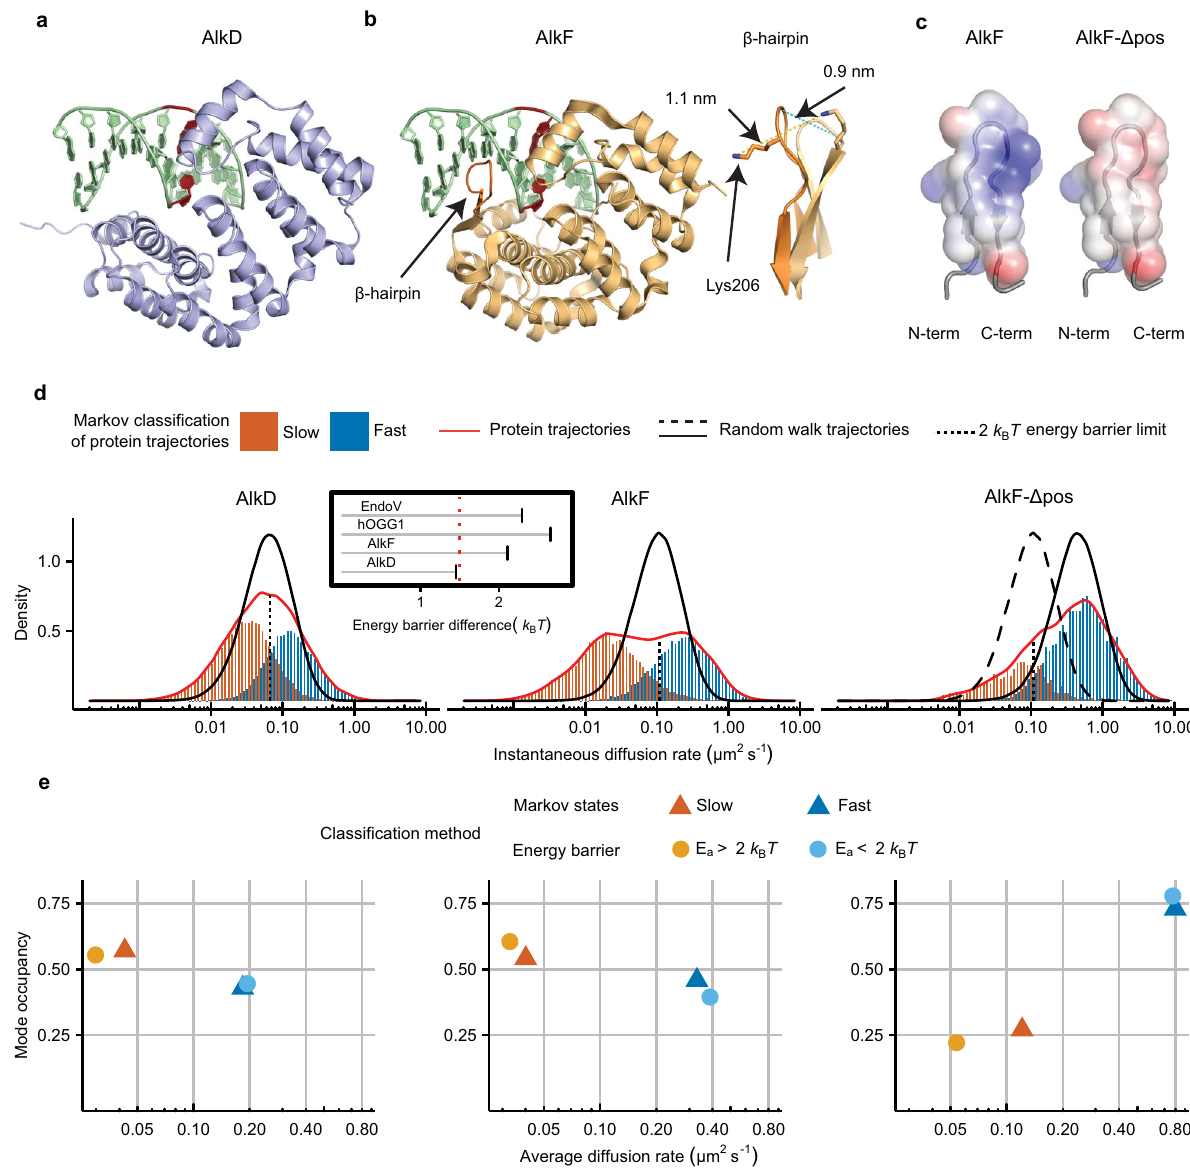
Fig. 2 DNA-scanning analysis of AlkD, AlkF, and AlkF- Δ pos. a Crystal structure of B . cereus AlkD binding to DNA with 3-deaza-3-methyladenine (red base). PDB code: 3JX7 4 . b Model of AlkF – DNA using the crystal structure of B. cereus AlkF without DNA (PDB code: 3ZBO 10 ) superposed onto AlkD bound to DNA. The β -hairpin of AlkF (dark orange; arrow) is protruding into the DNA major groove; Inset: a close-up view of the β -hairpin showing the fl exibility of the loop structure. c a close-up view of the wild-type AlkF and AlkF- Δ pos mutant, respectively, showing the difference in surface charge (blue/red correspond to 3/ − 3 k B Te – 1 ). d Overall instantaneous diffusion rate distributions (red curves) and classi fi cation of trajectories using a hidden Markov model, with the blue and orange histograms showing the individual distributions for the fast and slow modes of the scanning, respectively. These modes represent fractions of the movement with relatively higher and lower diffusion rates for each protein independently and do not necessarily correlate with those of other proteins. The black solid lines show the density distributions for the instantaneous diffusion rates for corresponding simulated random walks, and with the dashed line in the AlkF- Δ pos panel showing also the curve for wild-type AlkF for comparison. Vertical dotted lines show the border between high- and low-energy barrier modes for the kinetic model, de fi ned by the 2 k B T energy barrier limit; inset: energy barrier difference between the two modes of HMM analysis for hOGG1, EndoV, AlkD, and AlkF. The red dotted line shows the range of energy barrier variation of helical sliding (the data for hOGG1 and EndoV from Ahmadi et al. 11 ). e Comparison of average diffusion rate ( x axis) and mode occupancy ( y axis) for AlkD, AlkF, and AlkF- Δ pos calculated using the kinetic energy barrier method (circles) and the independent hidden Markov model